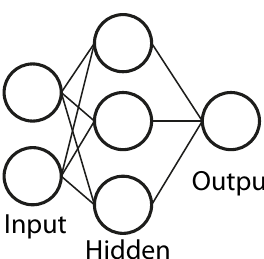
Figure 5. An Artificial Neural Network (ANN) with two input nodes, one hidden layer with three nodes, and one output node. Each line drawn between the nodes illustrates the forward flow of calculations in the